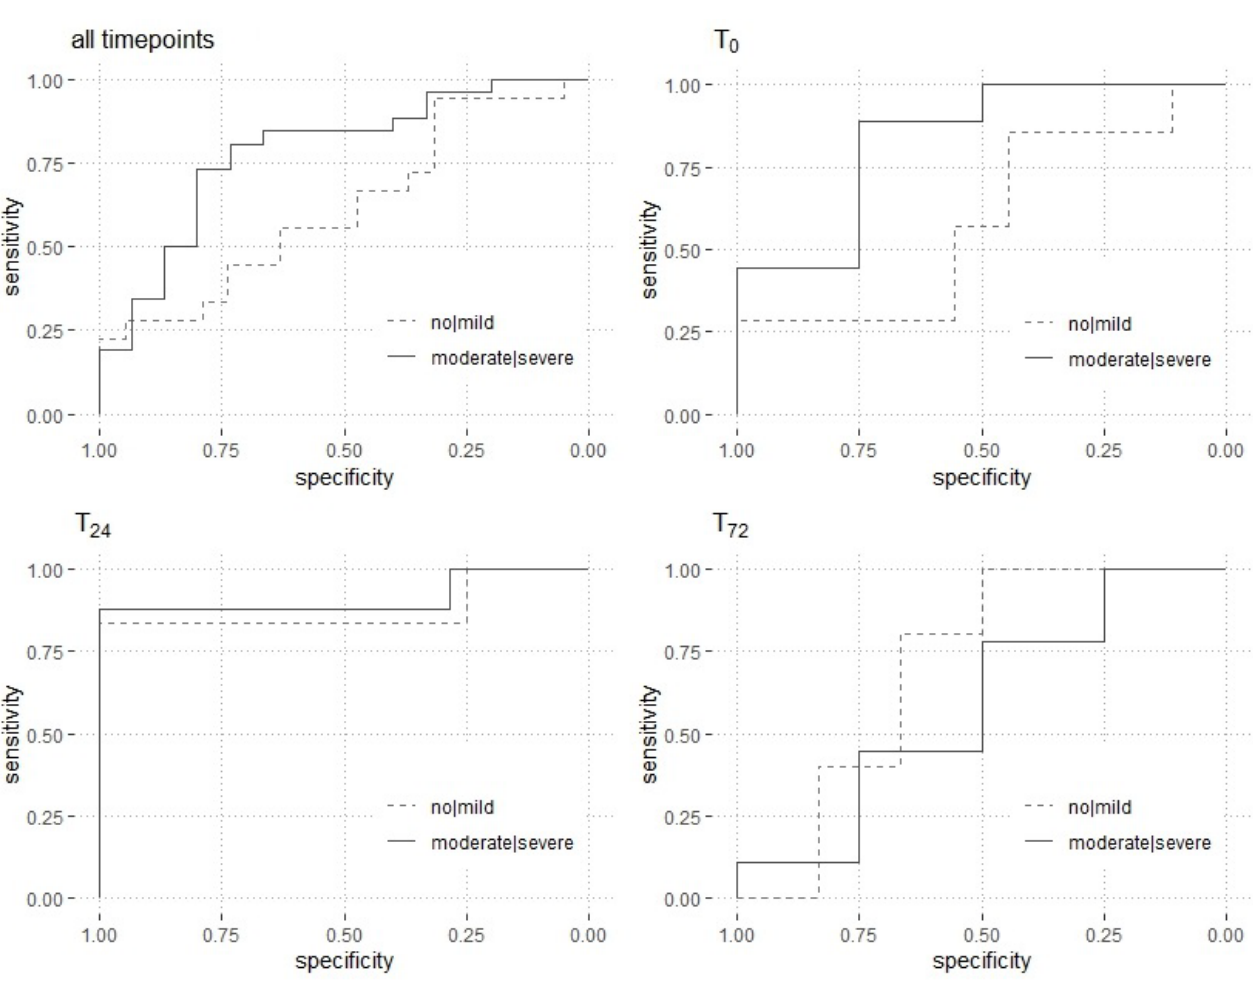
Figure 4. Prediction of in-hospital mortality. The receiver operating characteristic curves for the (Figure 4). A sensitivity of 0.86 and a specificity of 1.00 were calculated for a cut-off value of 43,012. The results of all analyses are shown in Table 2. mtDNA level, FIBTEM MCF × mtDNA level, EXTEM MCF × mtDNA level and TRAP × mtDNA Additionally, the COVID-19 patients were divided into adult respiratory distress level are shown. The curves are presented for each time point (t 0 , t 24 and t 72 ) individually, as well as syndrome (ARDS) subgroups (no/mild and moderate/severe) according to the Berlin for all time points. Abbreviations: EX.MCF = maximum clot firmness in the extrinsically activated definition of ARDS, and the prediction of hospital mortality was calculated [29]. Except for thromboelastometry assay; FI.MCF = maximum clot firmness in the fibrinogen-based thromboelas- t 72 , ROC analysis showed a sufficient prediction of mortality in the moderate/severe ARDS tometry assay; mtDNA = mitochondrial DNA; TRAP = thrombin receptor-activating peptide. subgroup. The results of the ARDS subanalysis are presented in Figure 5 and Table 3.